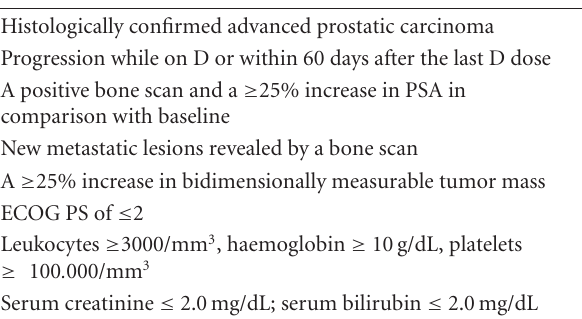
Table 1: Main eligibility criteria. Histologically confirmed advanced prostatic carcinoma Progression while on D or within 60 days after the last D dose A positive bone scan and a ≥ 25% increase in PSA in comparison with